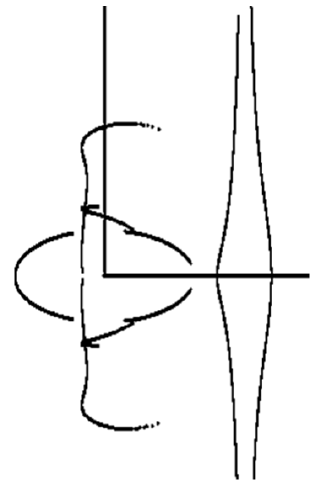
Figure 2. q = 1, KG = 80, and DK = 120.